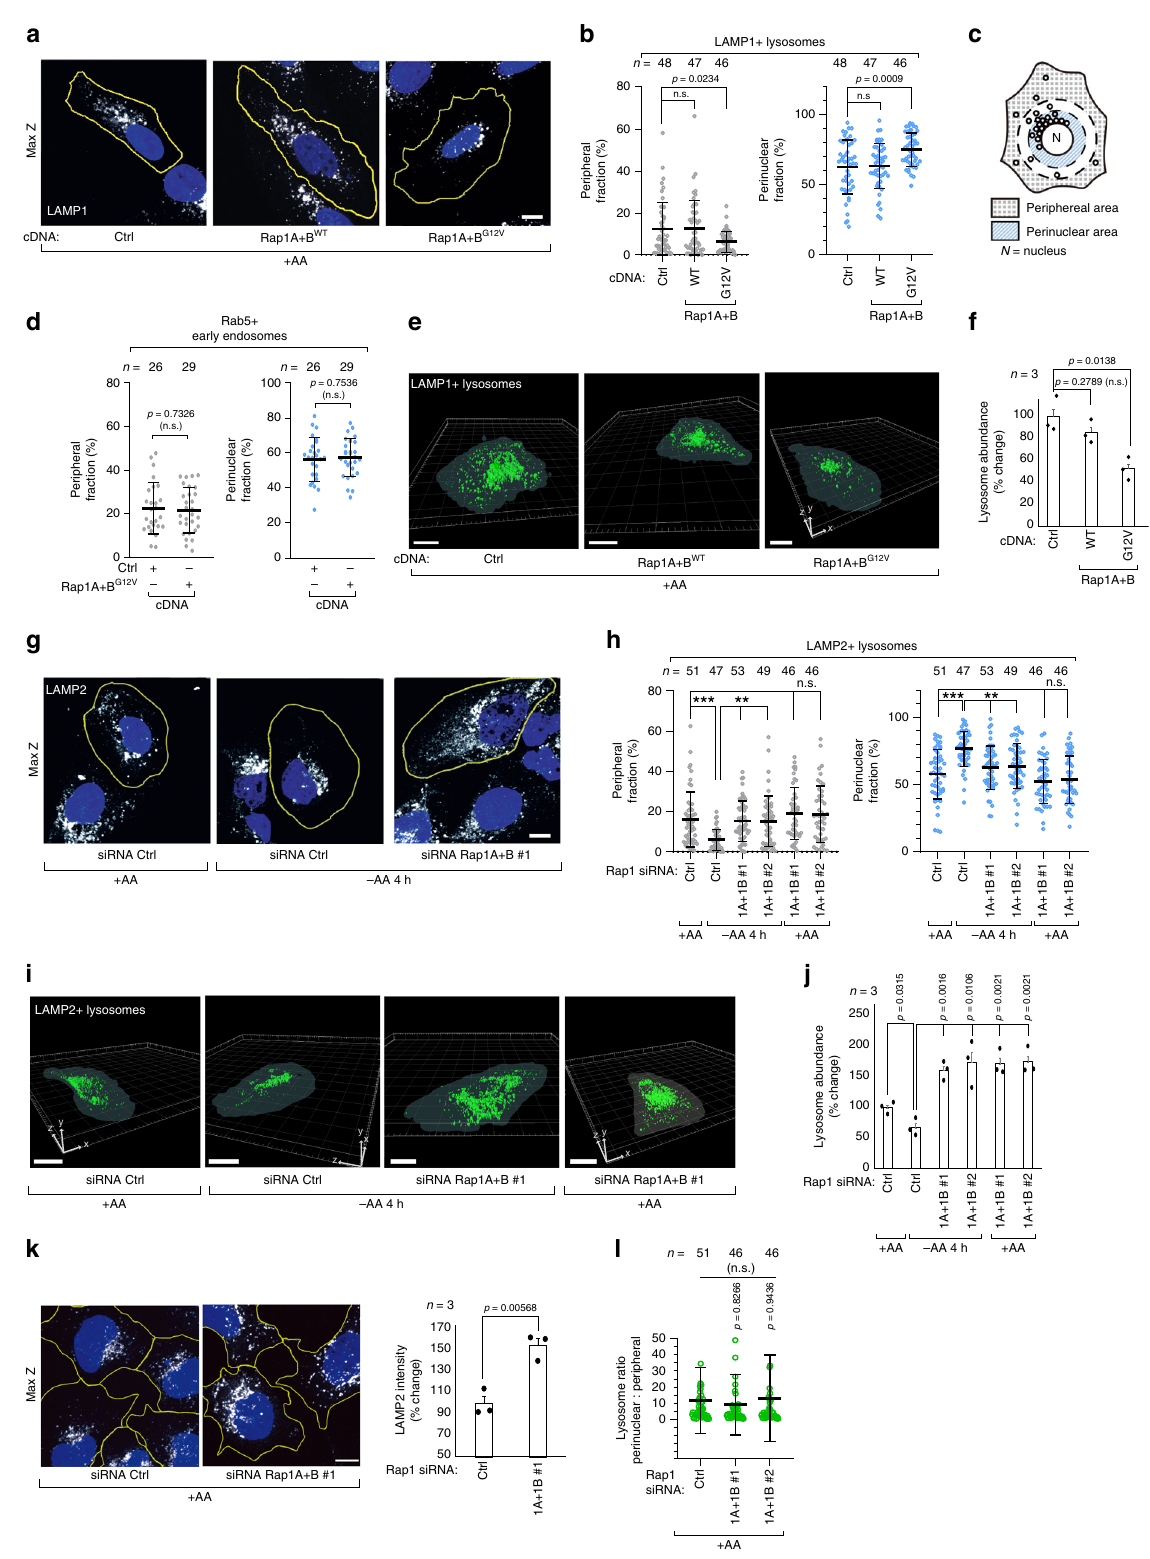
Rap1-suppression of lysosome abundance is dependent on lysosome degradative function . To better understand how Rap1 activation reorganizes lysosome architecture, we tracked mCherry-marked lysosomes over 4 h of amino acid starvation. In control cells, starvation induced a gradual re-localization of per- ipheral lysosomes to the perinuclear region and